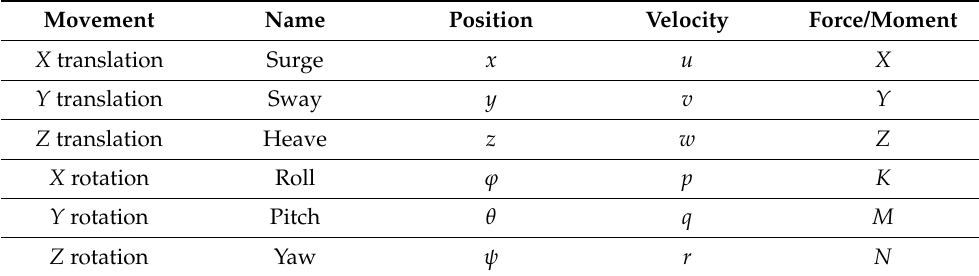
Table 1. Notation for underwater vehicle’s movements, positions, velocities, and forces. Movement